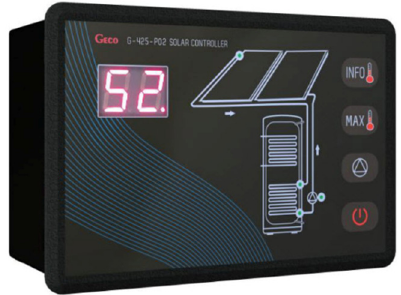
Figure 5. G-425-P01 Geco controller.